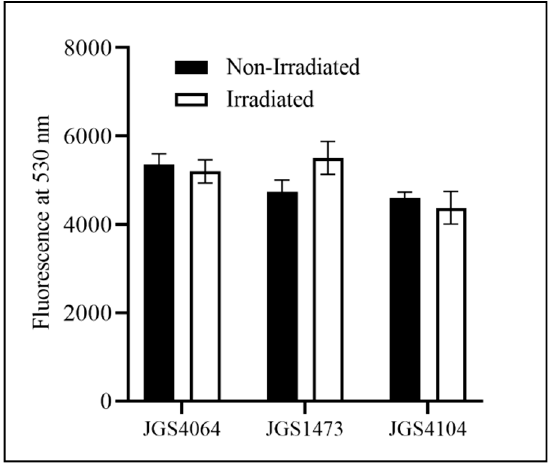
Figure 1. Fluorescence measured at 530 nm for eBeam-killed and non-irradiated (live cells) of three strains of Clostridium perfringens (JGS4064, JGS1473, and JGS4104) stained with Bac Light™ to determine the bacterial viability and cell wall integrity. Dark bar—non-irradiated CP cells; white bar—eBeam-killed CP cells (irradiated).